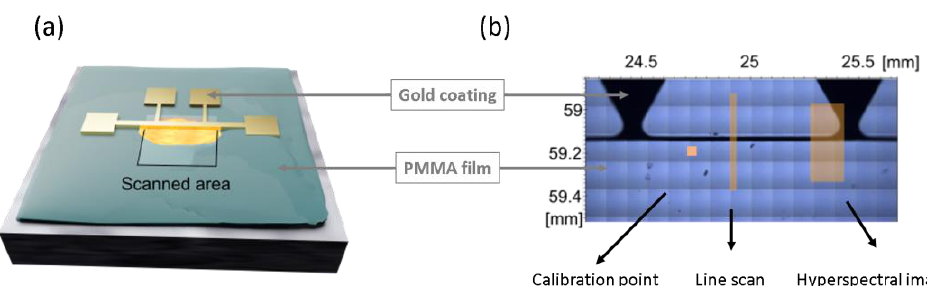
Figure 1. ( a ) Schematic representation of the heating device deposited on top of the polymer film. ( b ) Optical transmission image of the sample, showing the metallic wire in black with the three infrared measurement areas highlighted in orange.